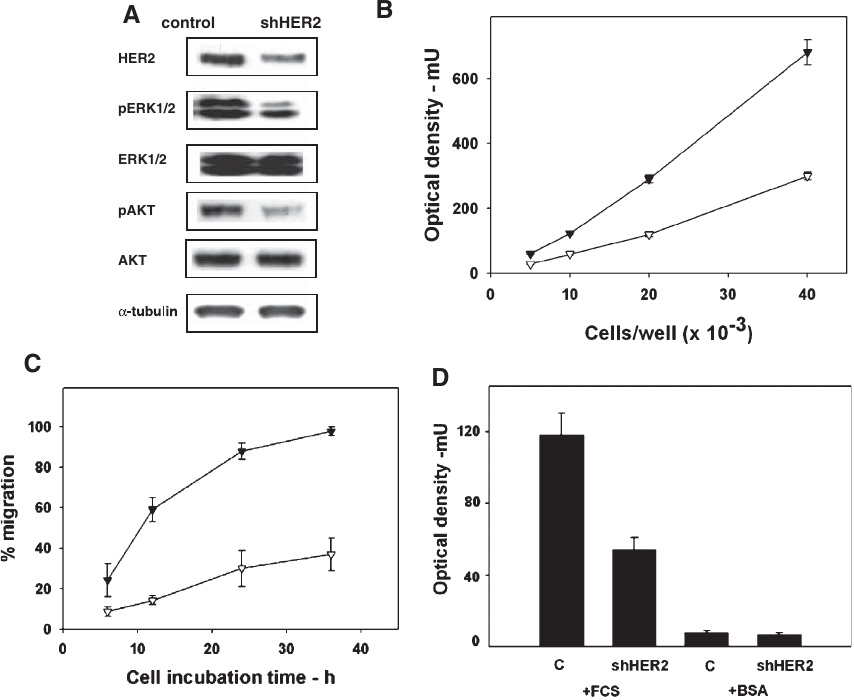
Fig. 1. HER2-silencing and effects on the migration of SKOV-3 cells. (A) HER2 and its signaling. Extracts were prepared from cells carrying stable HER2 silencing and control cells (carrying the empty vector) and used to immunodetect HER2, pERK1/2 (pT202/pY204 of ERK1 and pT185/pY187 of ERK2), ERK1/2, pAKT (pS473), AKT and (cid:2) -tubulin. pERK1/2 and pAKT detect the active form of the enzymes. The data are representative of several independent experiments. (B) Cell proliferation assay. The indicated amounts of cells were seeded in 24-well Costar plates, grown for 48h, fixed, stained with Crystal Violet, lysed and analyzed spectrophotometrically. Average of 4 experiments, using 2 different clones of HER2-silenced (open symbols) and control (filled symbols) cells ± SEM. (C) Wound-healing migration assay. Confluent cells were induced to migrate by scratching, fixed at the indicated time-points and stained with Giemsa stain. Migration is given as percentage of wound closure (i.e., distance moved by the cells) with respect to time 0 (100% opened wound). HER2-silenced (open symbols) and control (filled symbols) cells. Average of 4 experiments ± SEM. (D) Trans-well migration assay. Cells were applied to the upper chamber of trans-well membranes and grown overnight. Media added with fetal calf serum (FCS) or bovine albumin (BSA) was present in the lower chamber. The migrated cells were fixed, stained with Crystal violet, lysed and analyzed spectrophotometrically. Average of 3 experiments ±